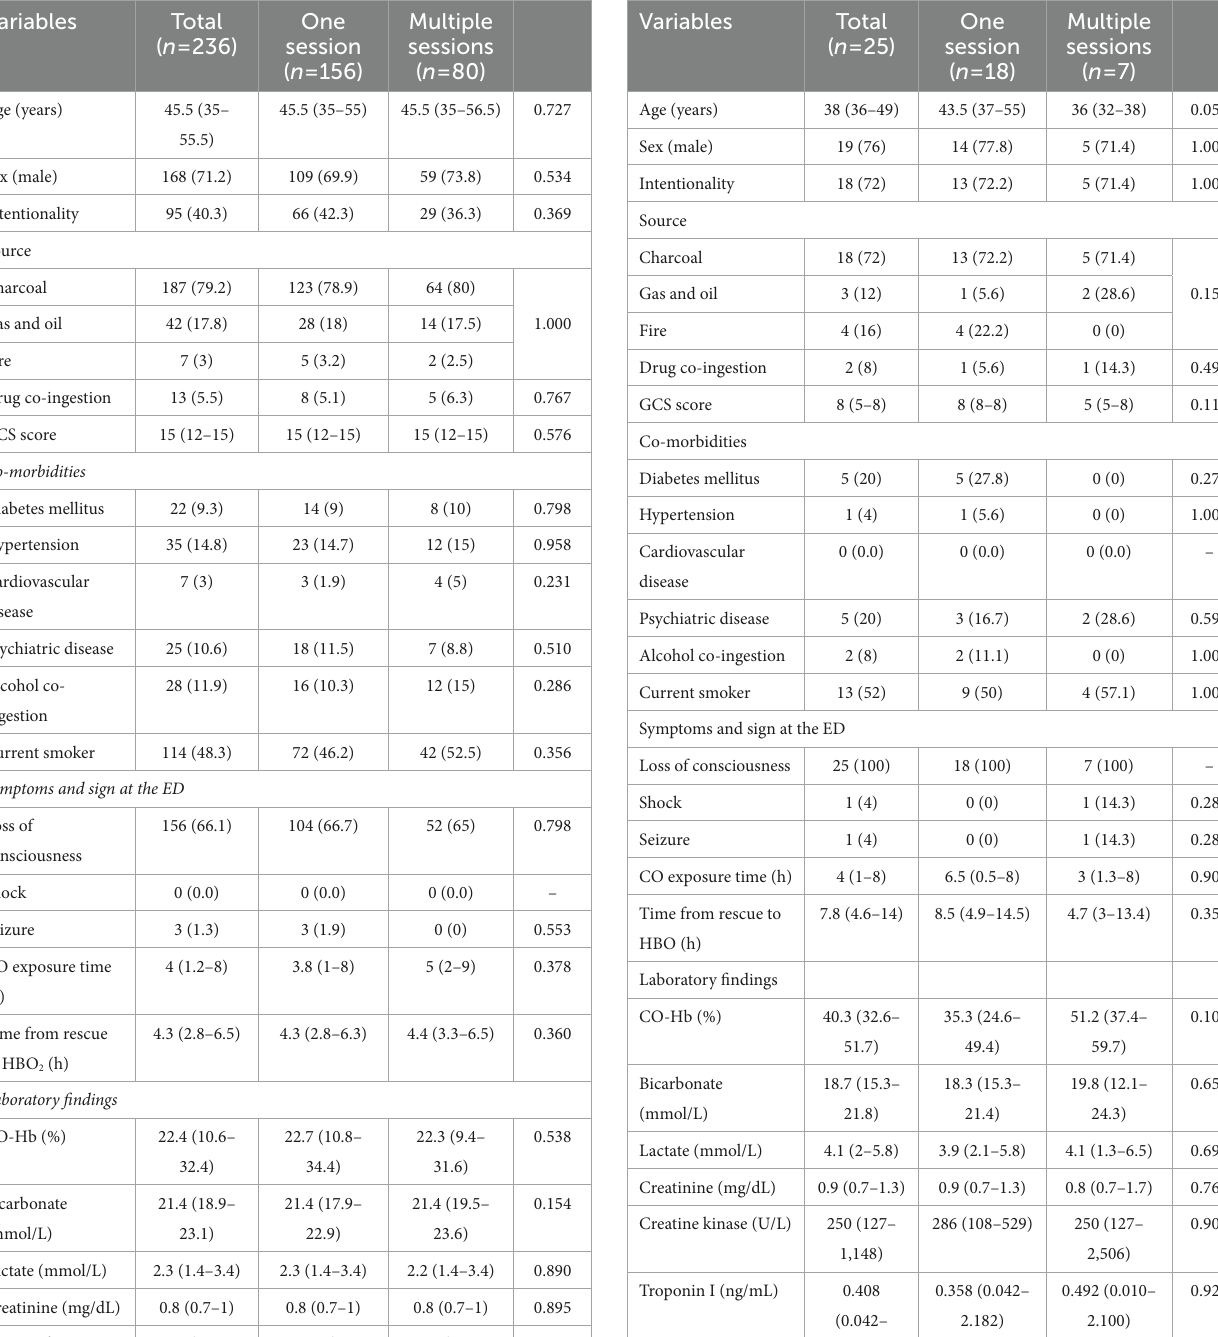
TABLE 4 Baseline characteristics in the invasive mechanical ventilation cohort.